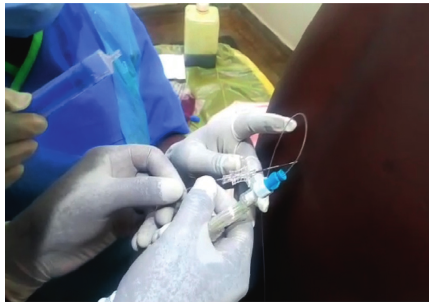
Figure 2: Threading catheter into the intrathecal space.